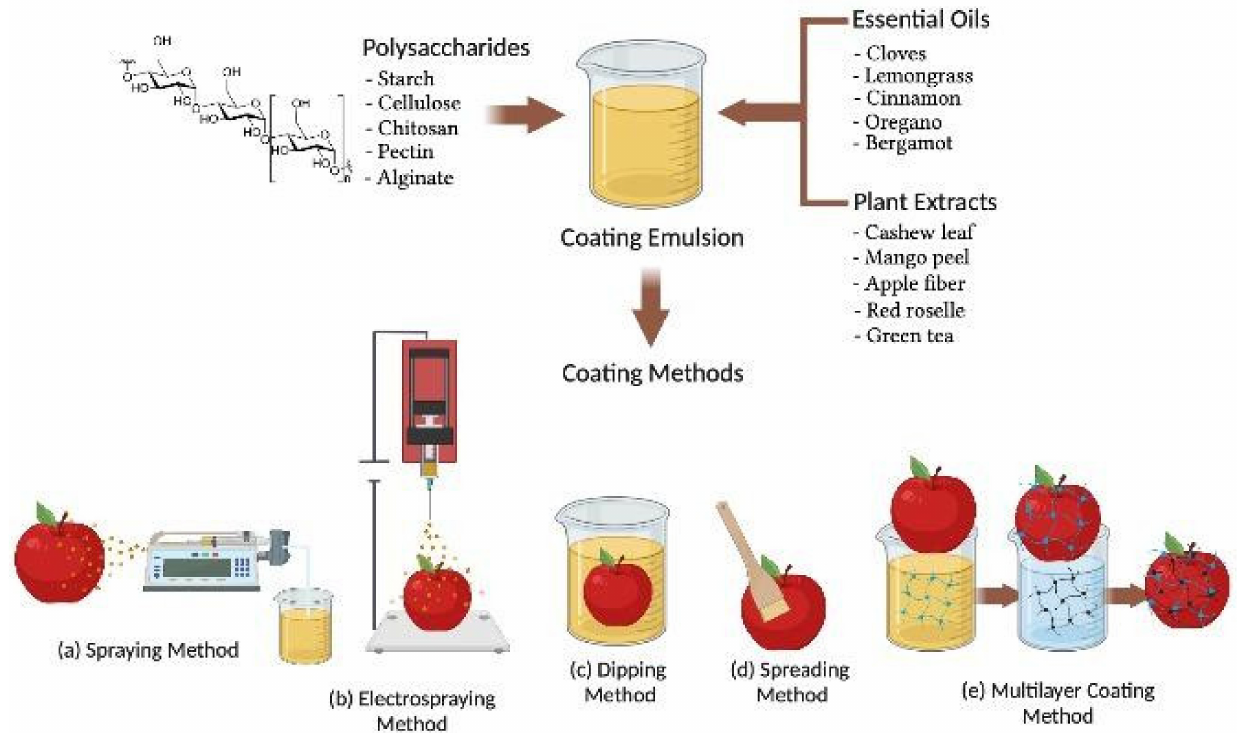
Figure 1. Schematic representation of biodegradable and edible active coating applications via ( a ) spraying; ( b ) electrospraying; ( c ) dipping; ( d ) spreading; and ( e ) multilayer coating methods, employed in the postharvest treatment of